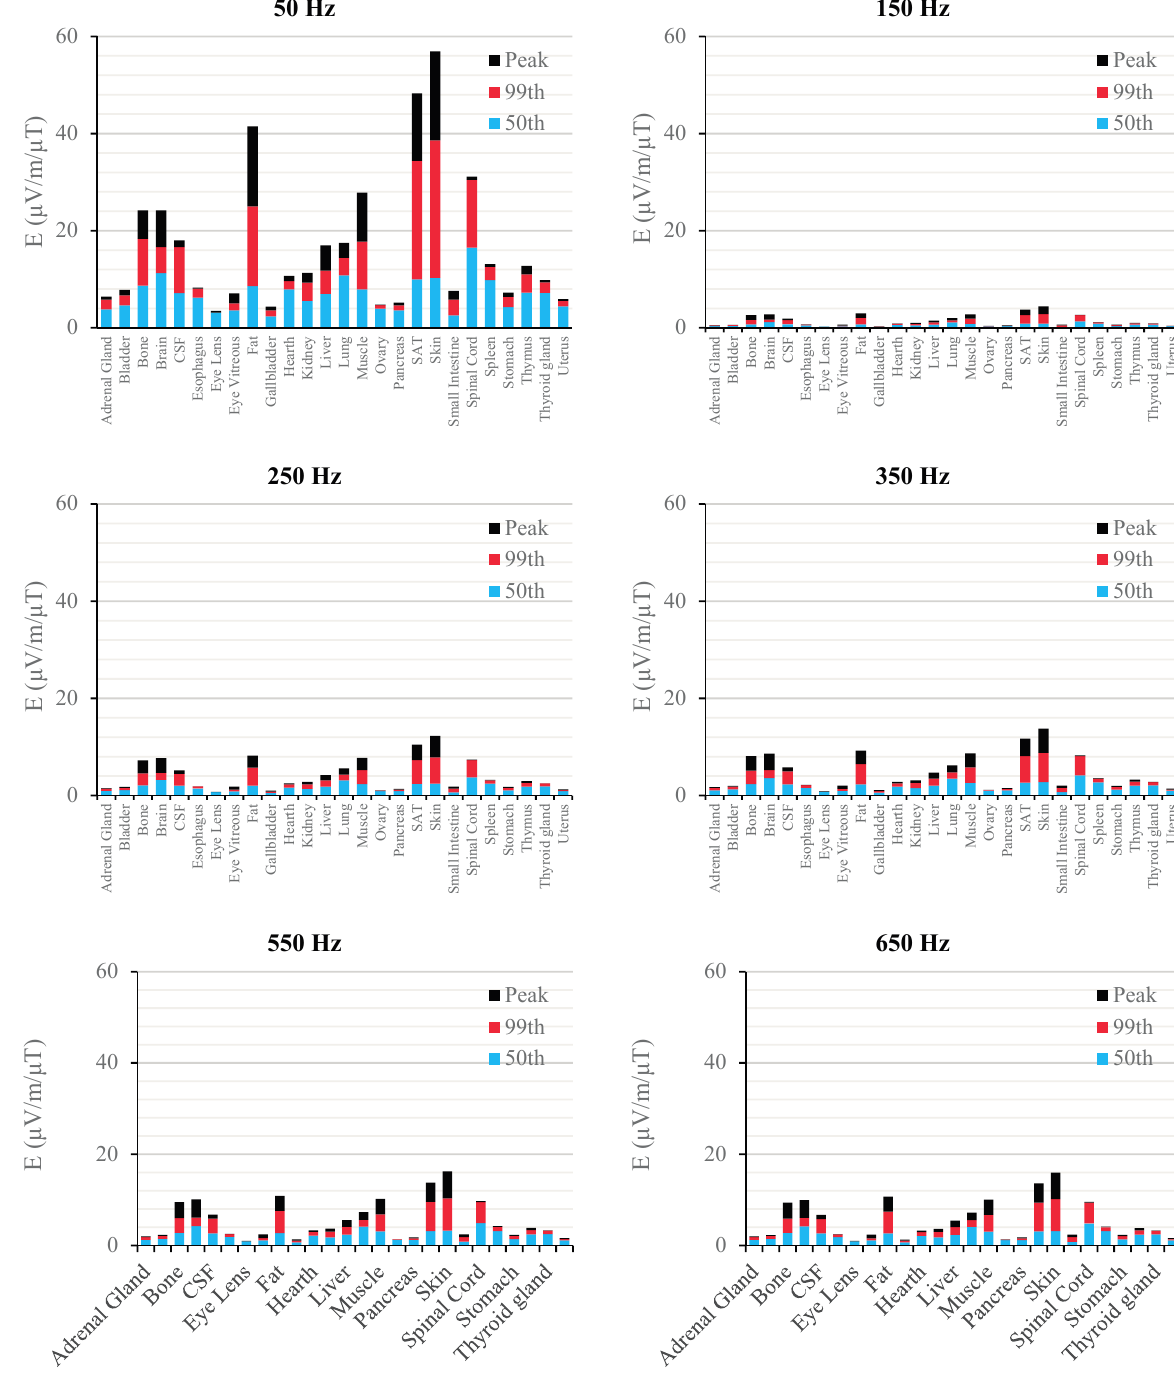
Figure 7. E ( μ V/m) per μ T of 50 Hz B peak induced in foetal tissues at 9 mGA for all the harmonic frequencies considering the standard EN 50160 for the HV power supply networks. The bars indicate the E 50th (blue), the E 99th (red) percentiles and the E peak (black) of each